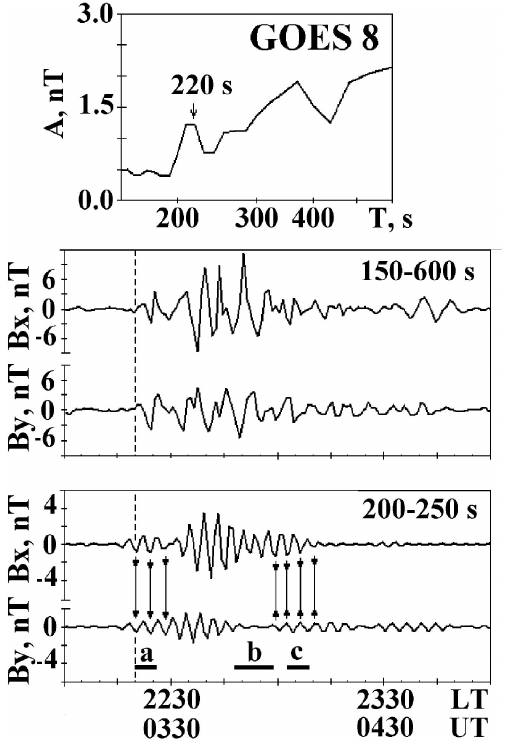
Fig. 3. The same as in the previous figure, but for GOES 8.